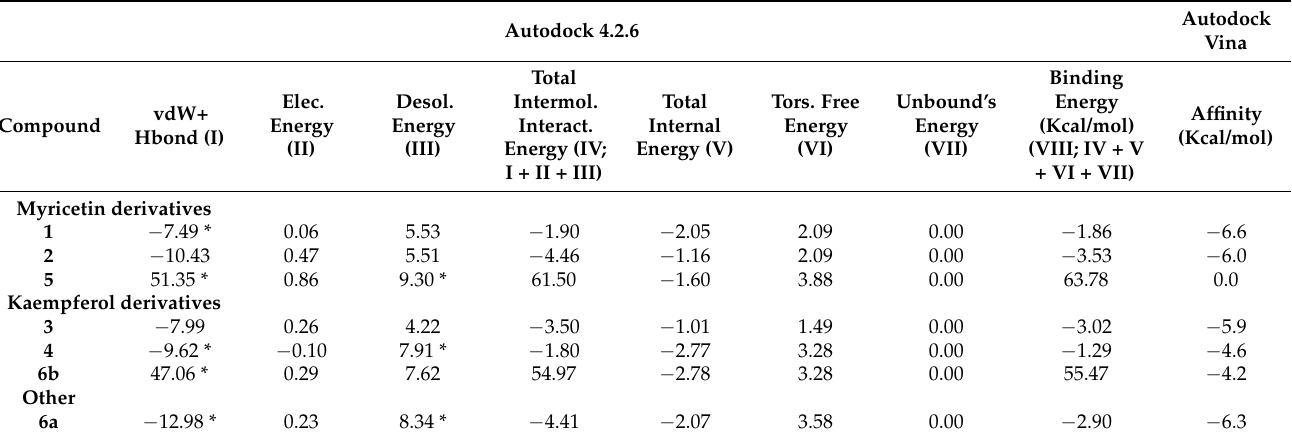
Table 5. Obtained binding energy of the compounds of interest ( 1 to 6 ) from Autodock 4.2.6 compared to Autodock